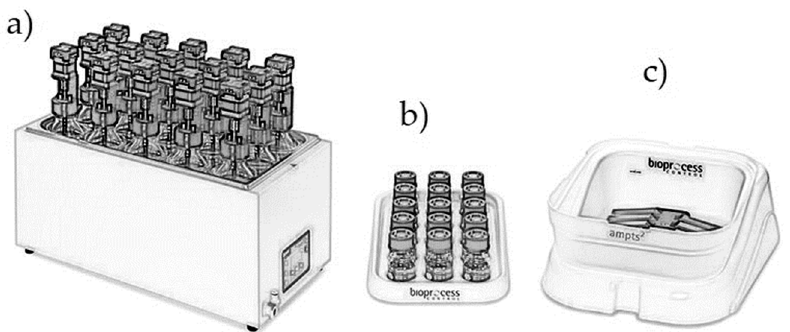
Figure 2. The AMPTS II ® analytical device: ( a ) Sample incubation unit with bottles and mixers. ( b ) Carbon dioxide absorption unit. ( c ) Flow cell array (based on “Bioprocess Control” website [25]).